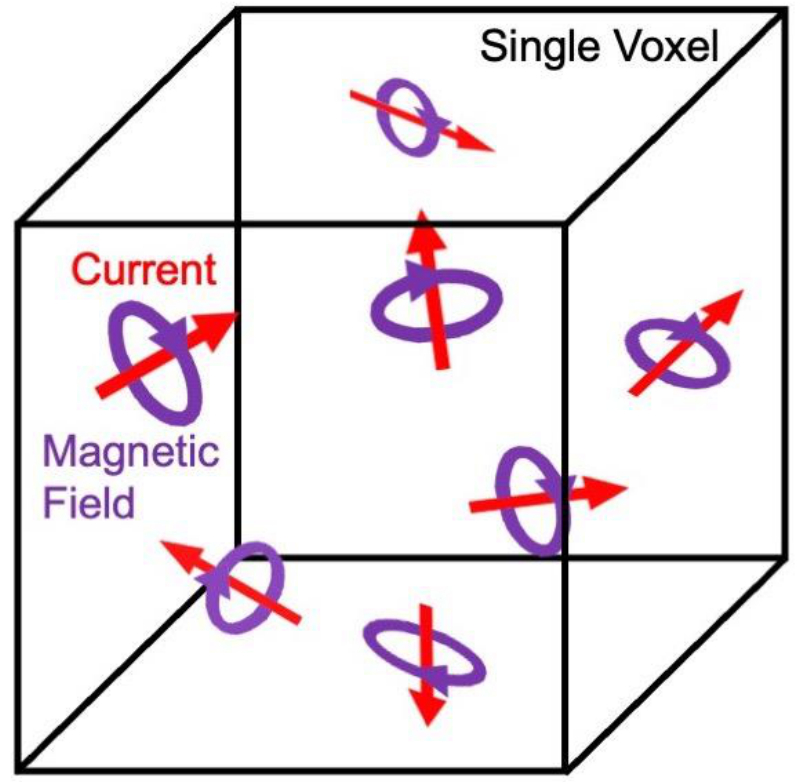
Figure 10. If the current (red) is heterogenous throughout a single voxel, the biomagnetic field (purple) will also be heterogenous. The resulting phase shift averaged over the voxel will be small, but the inhomogeneous biomagnetic field could cause the spins to dephase, shortening T 2 *.